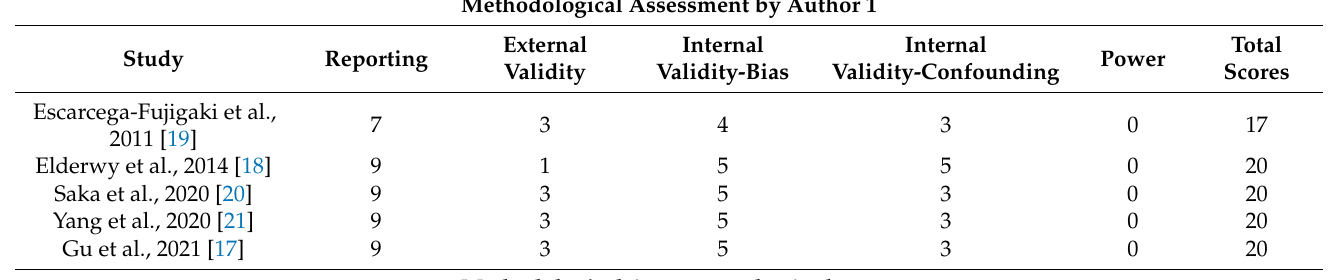
Table 3. Downs and Black scale scores for the included studies and the total scores and inter-observer agreement (kappa statistics).